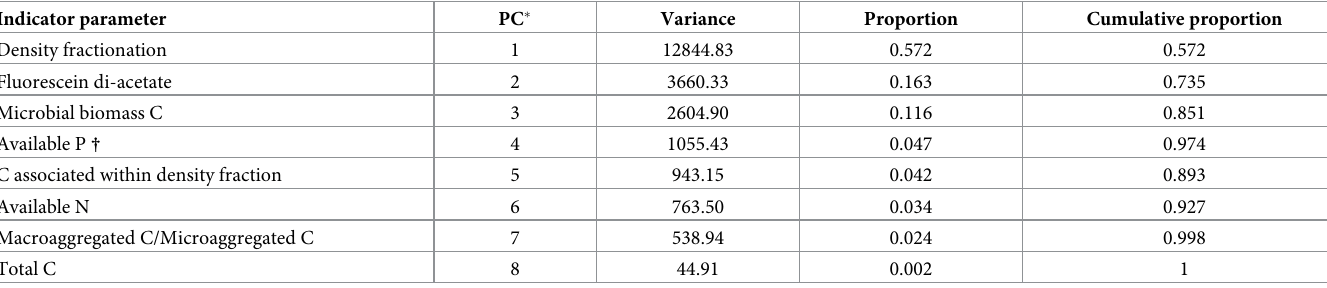
Table 3. Proportion and eigenvalues of the selected indicators for calculation of weighted additive soil quality